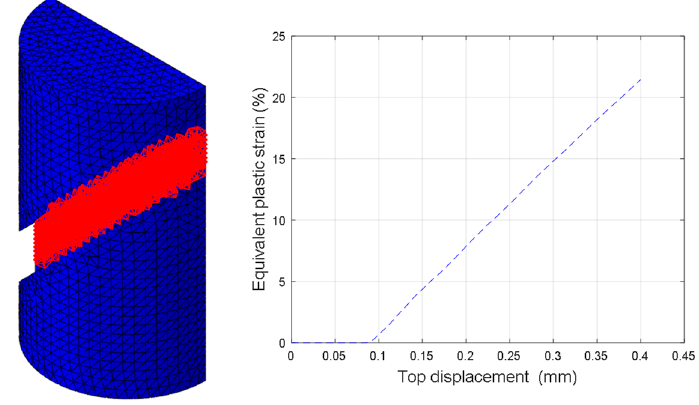
Figure A2. Evolution of the numerical value of ε eq in the notch section as a function of d